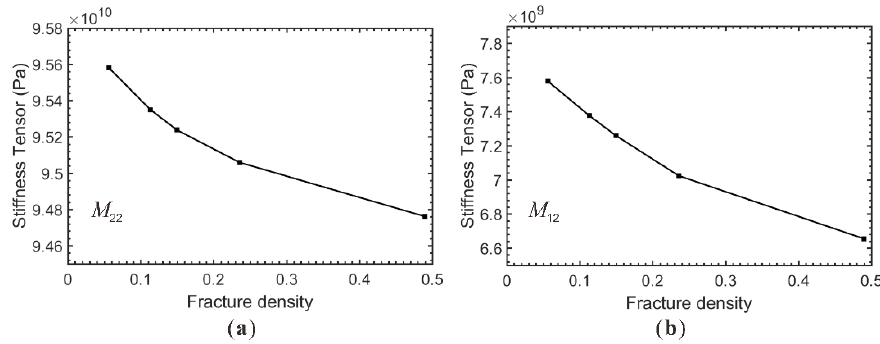
Figure 4. Effective stiffness tensors M 22 ( a ) and M 12 ( b ) for 2D fracture model.